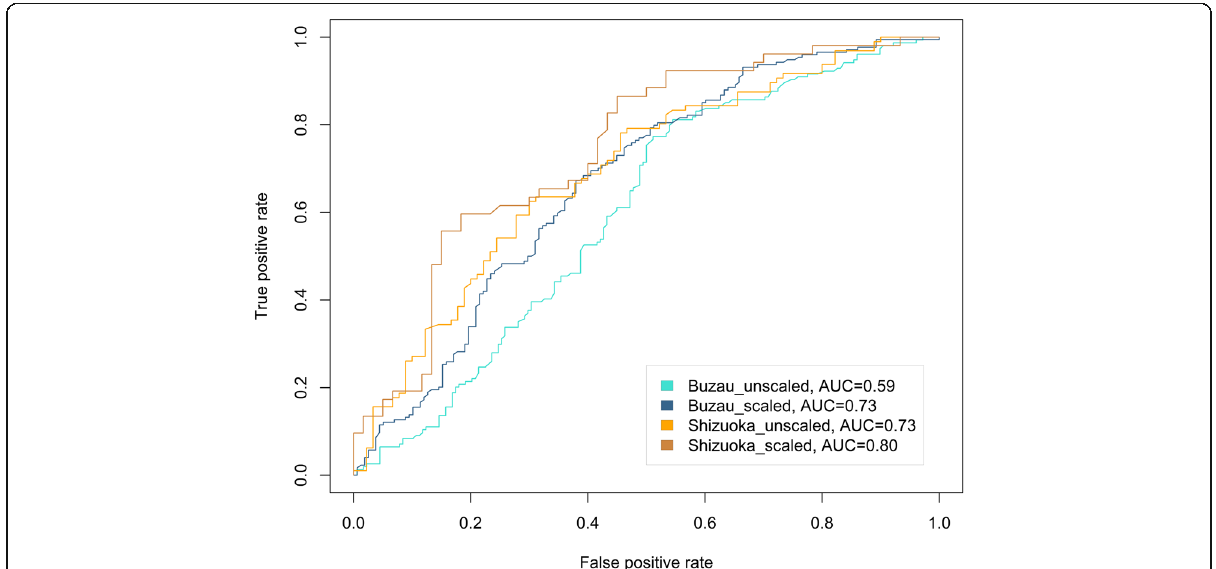
Fig. 7 Model accuracy, measured using